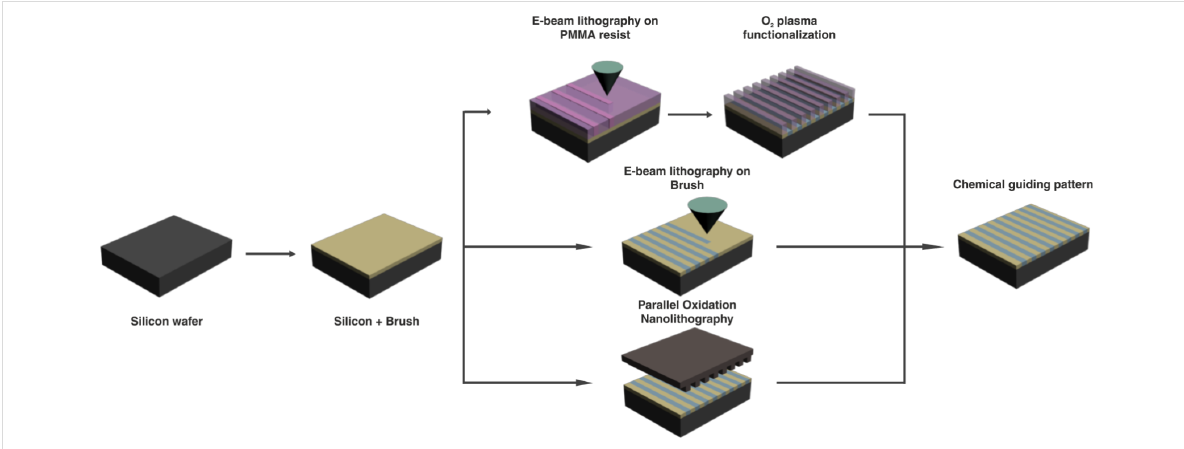
Figure 1: Schematized description of the selected chemical epitaxy DSA processes performed on grafted brush layer on a silicon substrate. The method in the top part of the figure uses EBL on a PMMA resist and ulterior oxygen plasma functionalization (two-step process), while the other two nanolithography methods (middle and bottom) are performed in absence of a resist (direct writing).